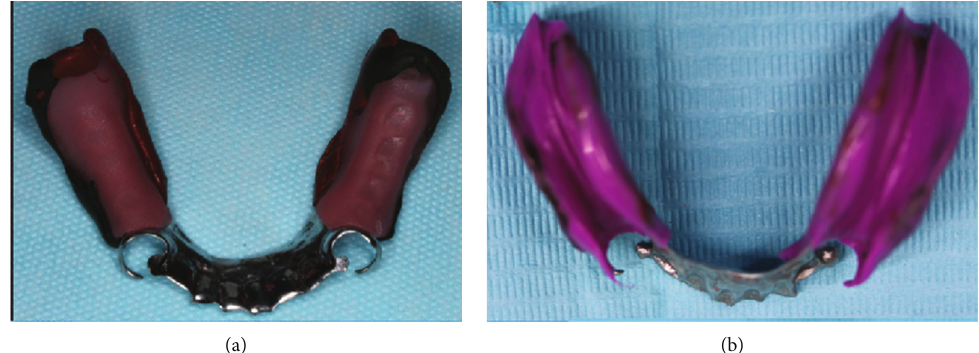
Figure 18: (a) Border molding on the distal free end saddle. (b) Final impression with medium body.